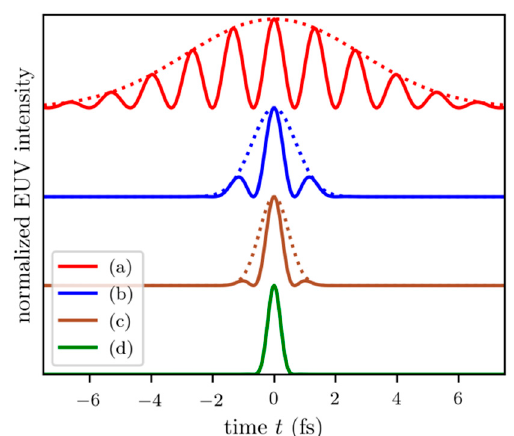
Figure 3. Normalized intensity of EUV excitation pulses (solid line) in the time domain corresponding to the EUV spectra shown in Figure 4a–d. Pulse train envelopes are also shown (dotted lines). The envelope full width at half maximum (FWHM) pulse durations are ( a ) 6.7 fs, ( b ) 1.7 fs, ( c ) 1.1 fs, and ( d ) 474 as.